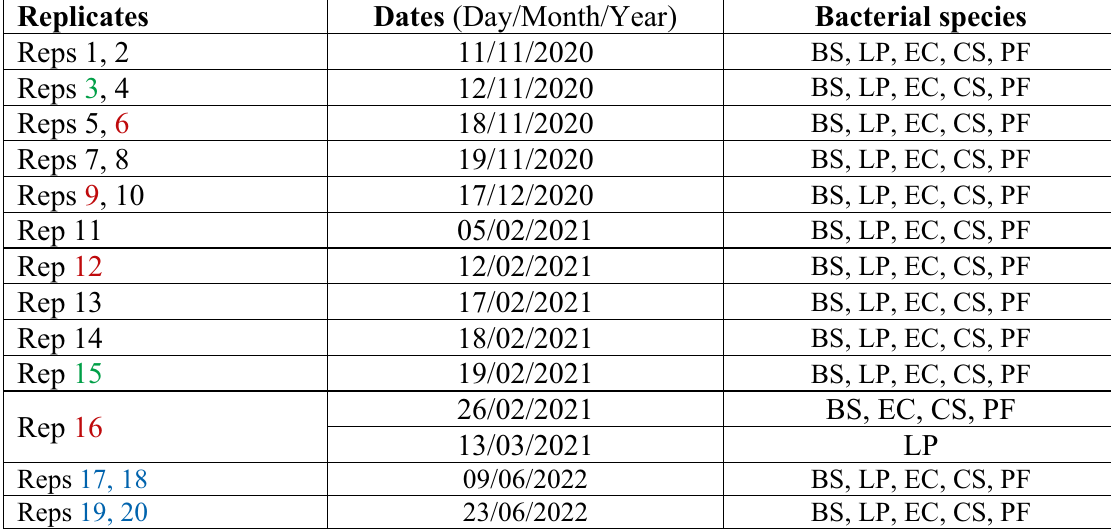
Table 1. Details regarding sample replicates deposited on stainless steel. Rep: Replicate . Replicates marked in green colour are samples used in validation set and red colour are used in the first test set (‘Test1’) and blue colour are used in the second test set (‘Test2’). FTIR images of replicate 2 were not successful because of malfunction of the imaging system and for this reason are omitted from further analysis. BS: Bacillus subtilis ; LP: Lactobacillus plantarum ; EC: Escherichia coli , CS: Cronobacter sakazakii ; PF: Pseudomonas